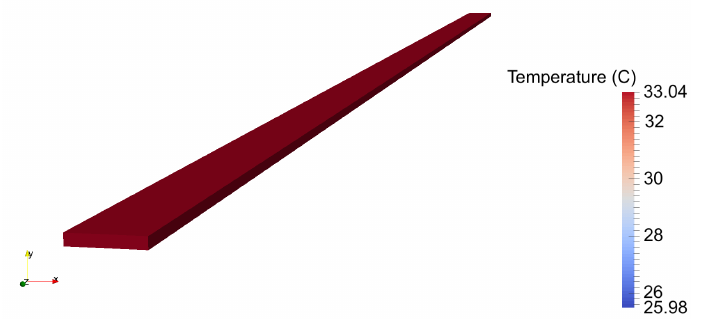
Figure 16. Temperature field at t = 50-s term for ω 1 = 2.45 GHz, when the electric field is polarized in the direction of the